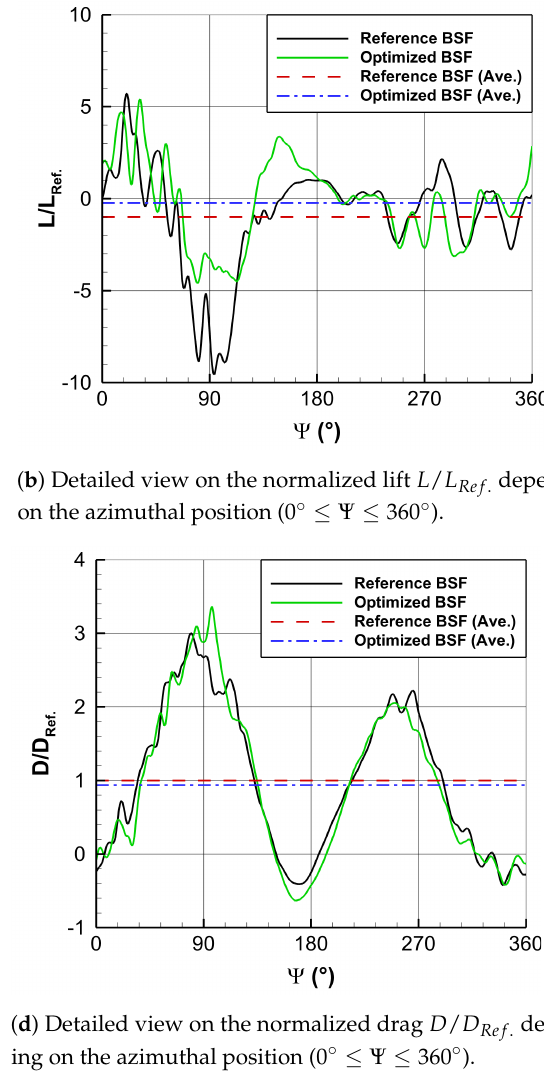
Figure 13. Comparison of the aerodynamic forces between the optimized and the reference BSF. The forces are shown for a single BSF and they are normalized by the average values of the reference